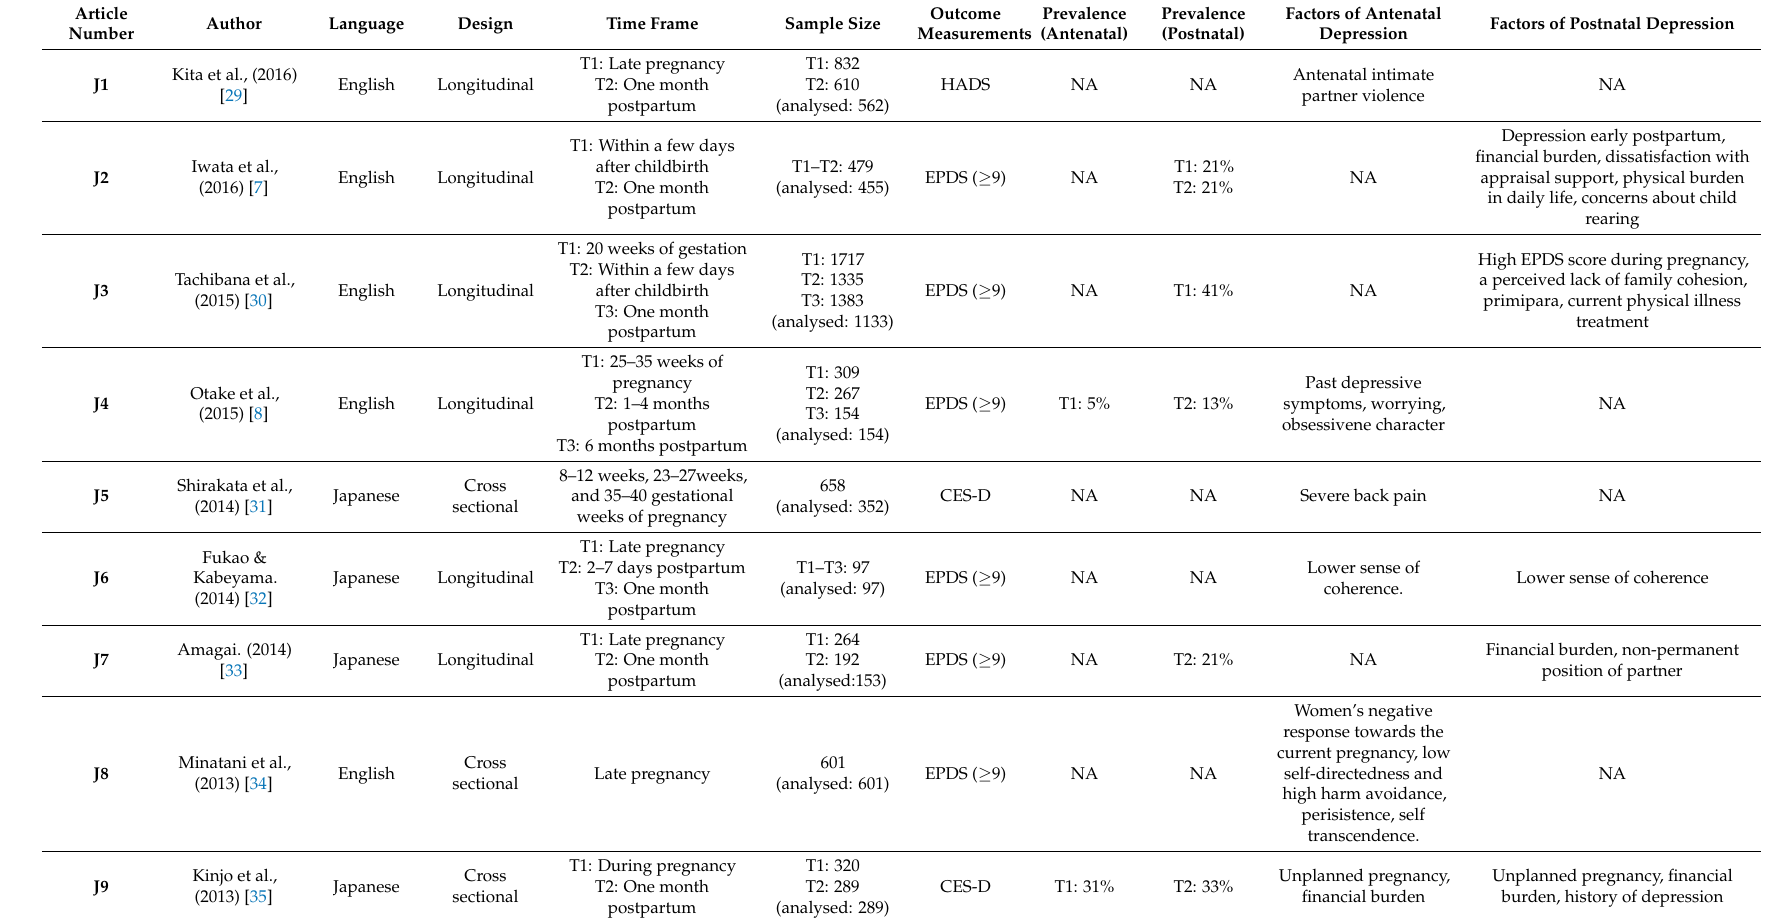
Table 2. Factors related to perinatal depression